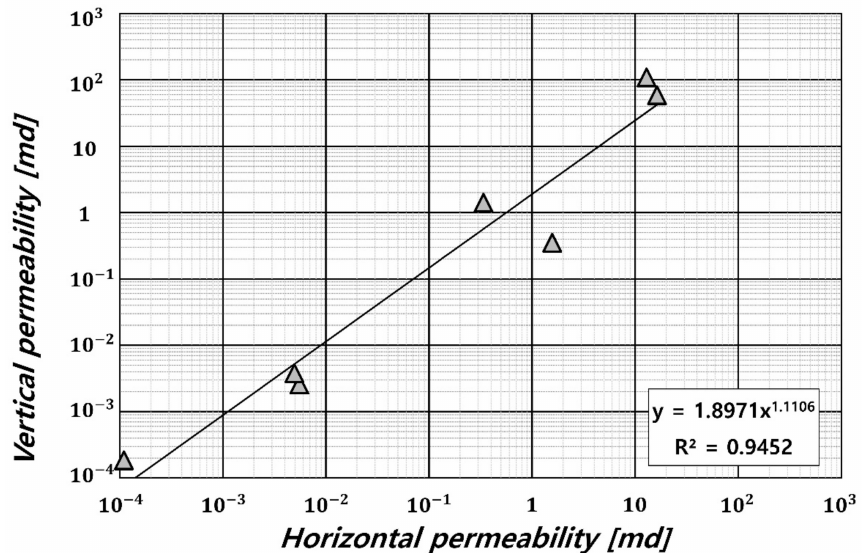
Figure 9. Relationships between vertical and horizontal